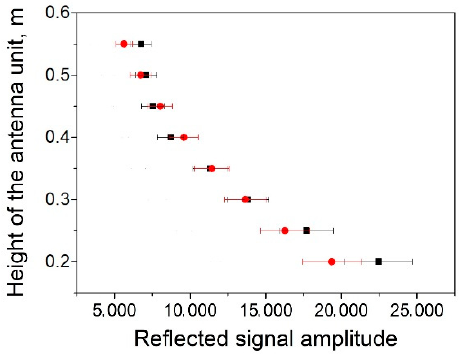
Figure 2. Results of calibration of antennas No. 278 ( ■ —experiment, ● —theory). Horizontal bars show the scatter of ±8%.